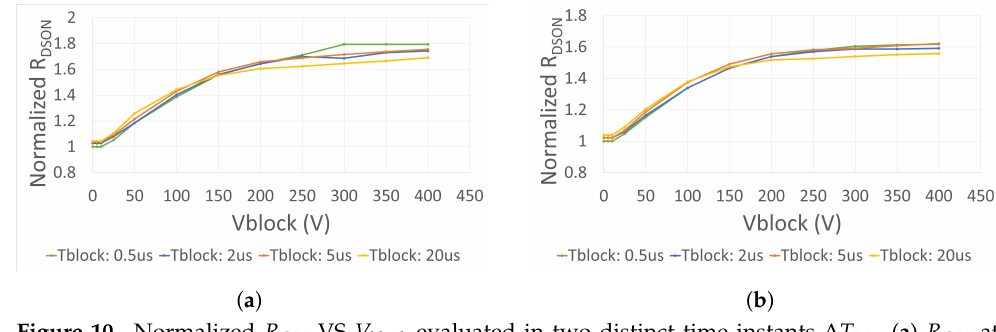
∆ T M = 400 µ s for different T block